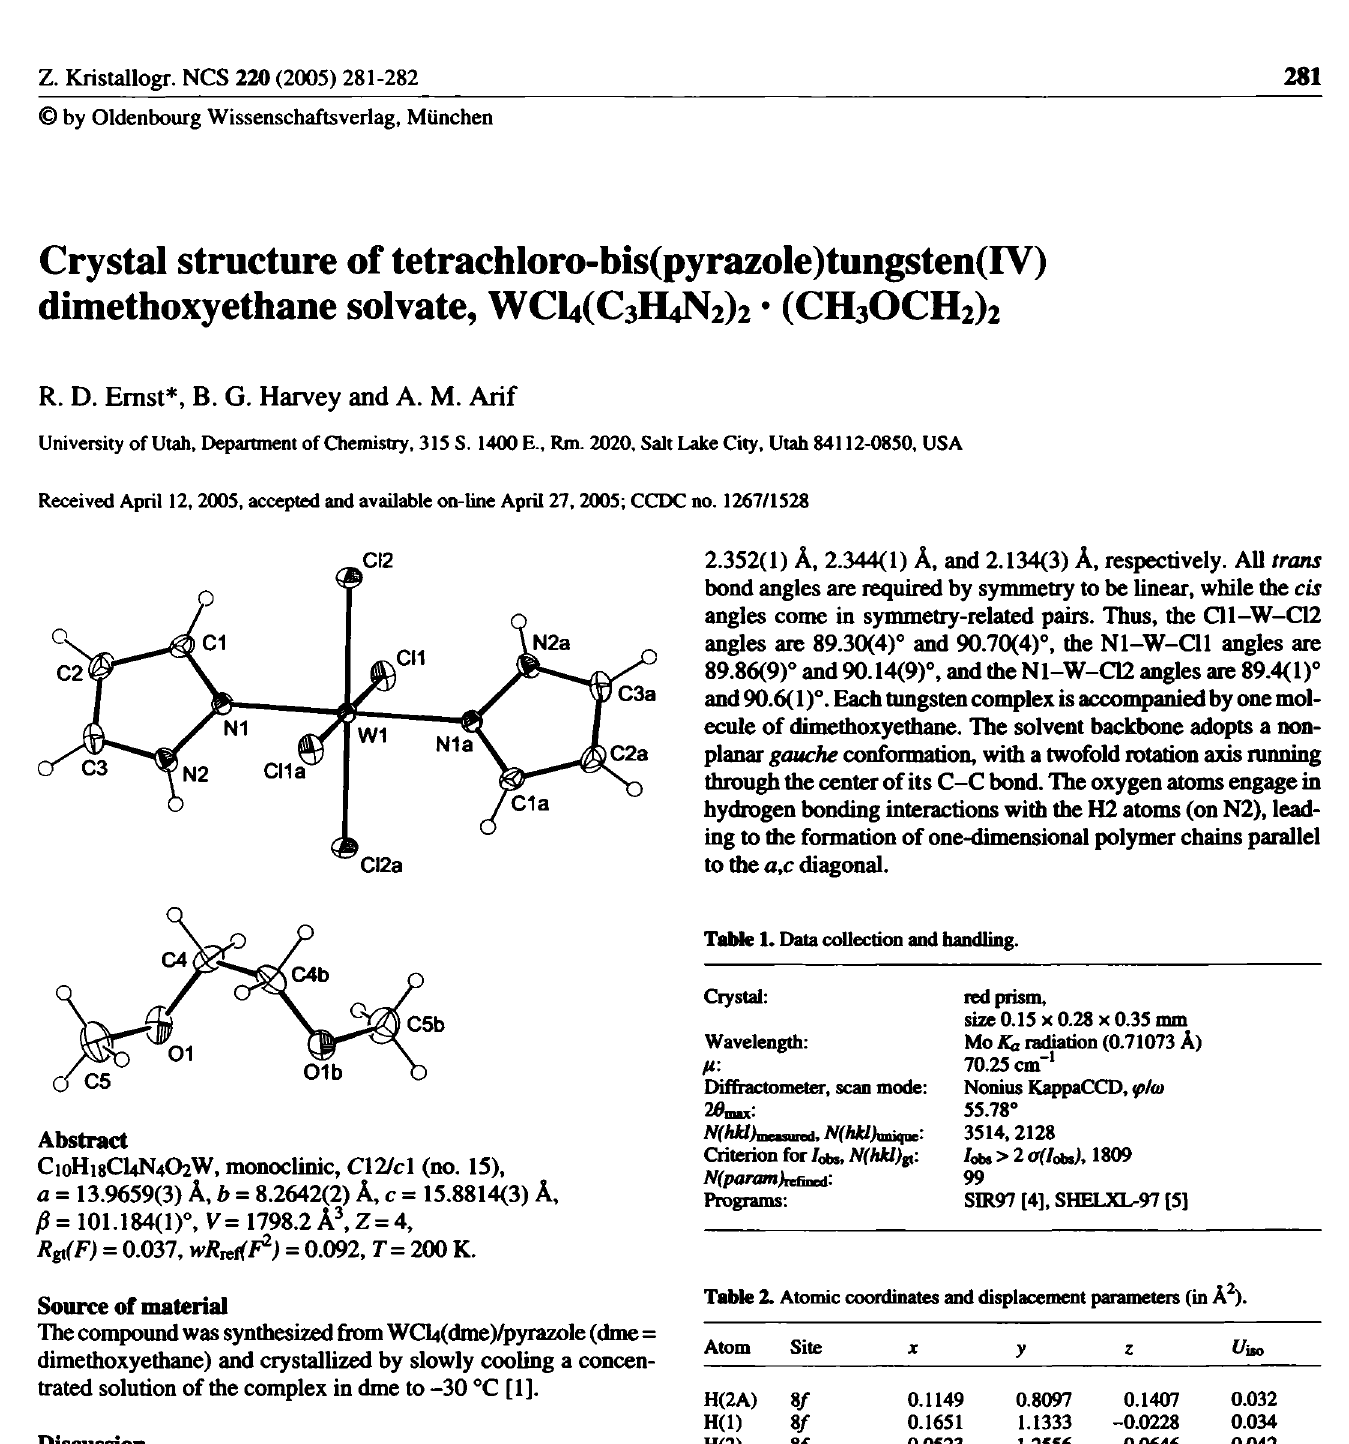
Table 2. Atomic coordinates and displacement parameters (in A 2 ).